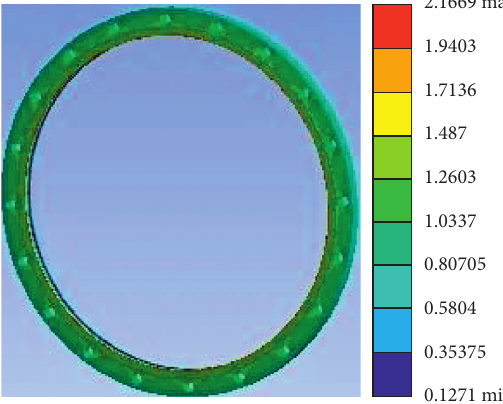
Figure 11: Cloud diagram of total flange deformation.